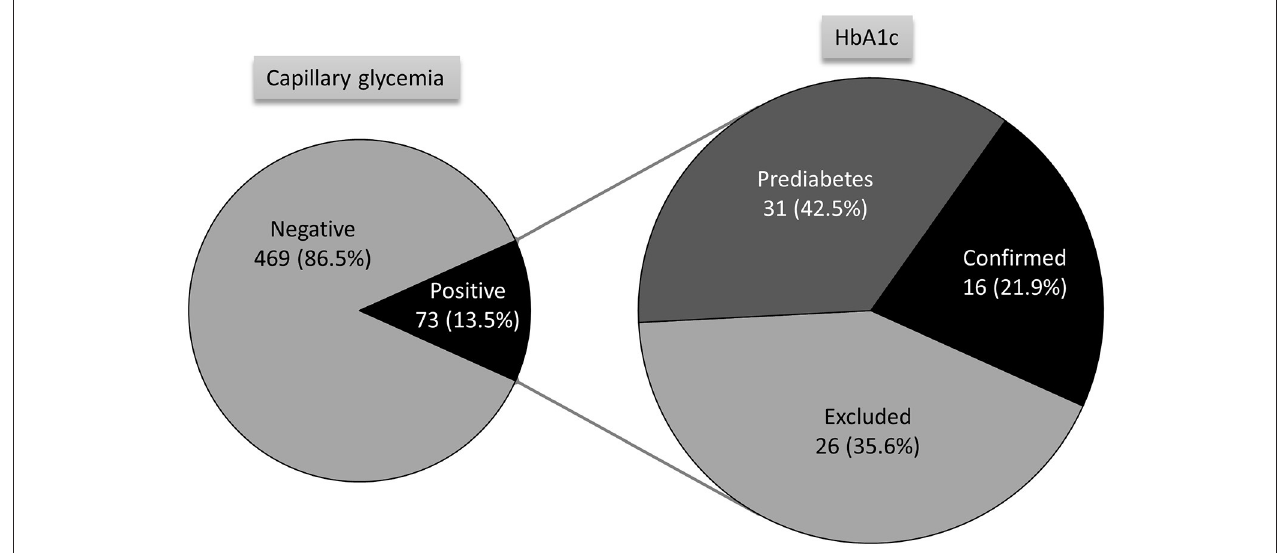
FIGURE 2 | Results of the screening for capillary glycemia and diagnosis confirmation by HbA1c testing performed using point-of-care test devices.